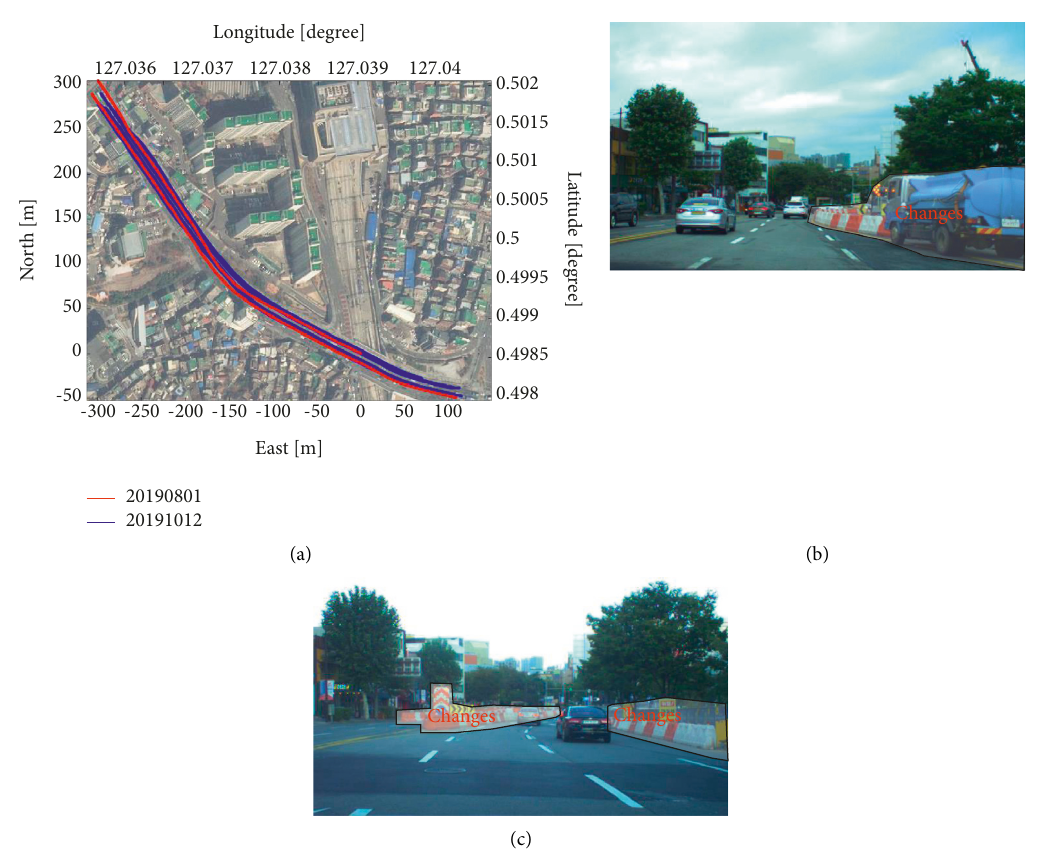
Figure 18: Test site for experiment: Wangsimni-ro in Korea. (a) Global trajectories, (b) base map environment at August 1, 2019, and (c) present map environment at October 12, 2019.